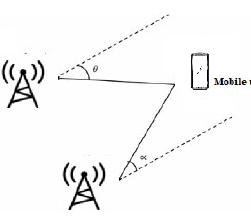
Table 2. Comparison of signal measurement techniques.